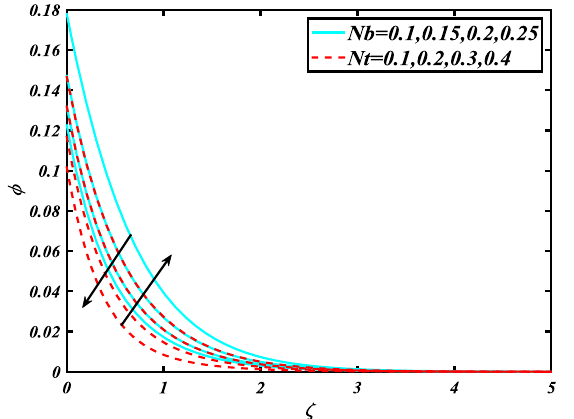
Figure 11. Significance of Nb & Nt for φ .